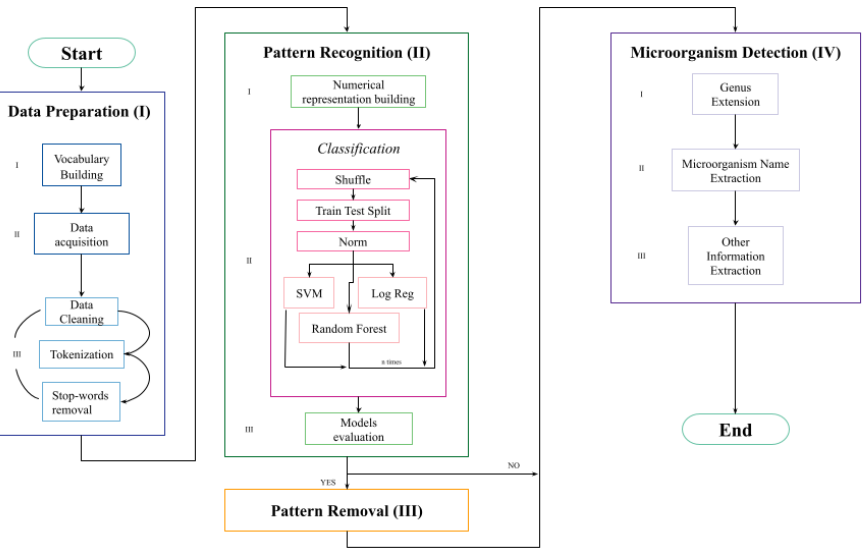
Figure 1. Complete schema of the pipeline. It can be divided into 4 main sections: data preparation, pattern recognition and removal, and microorganism detection.